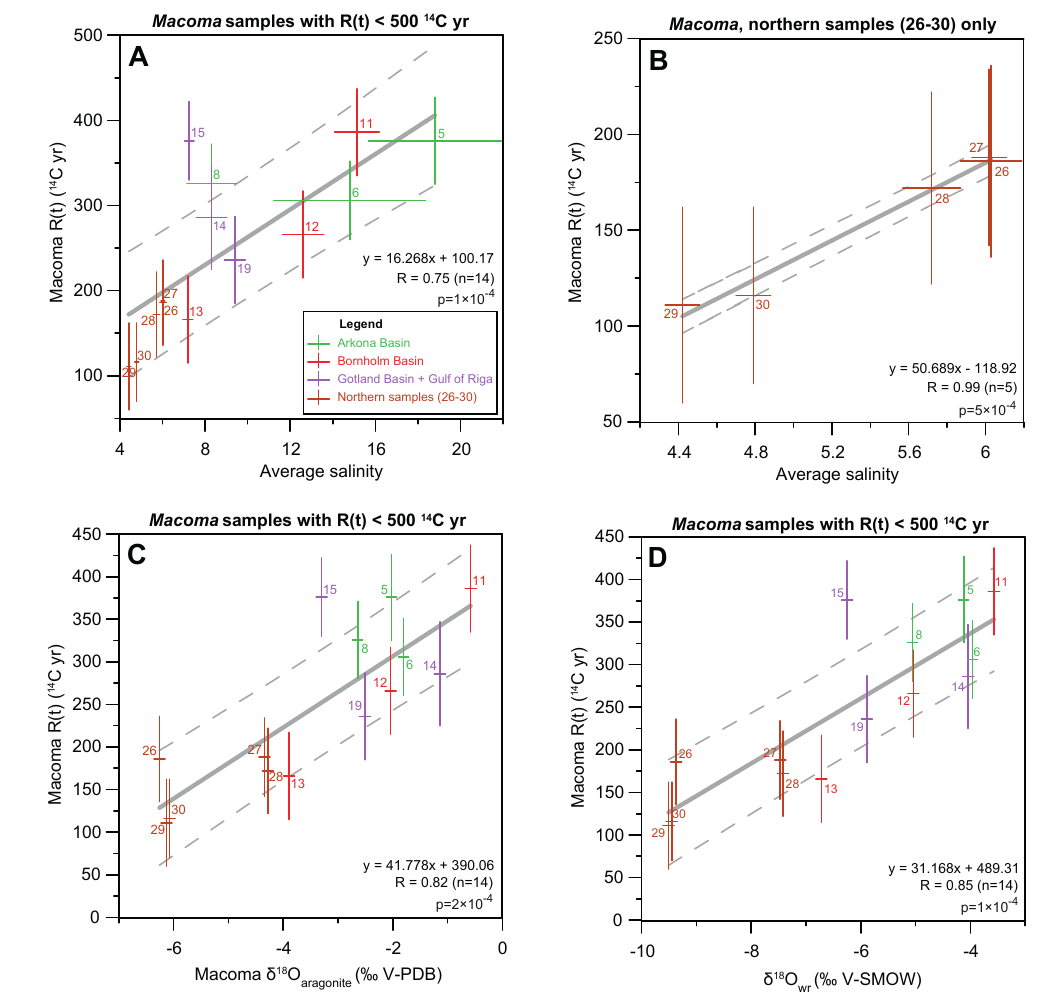
Fig. 5. (A) R(t) vs. average salinity for Macoma samples with R(t)< 500 14 Cyr. (B) R(t) vs. average salinity for northern samples (locations 26–30) only. (C) R(t) vs. δ 18 O aragonite for Macoma samples with R(t)< 500 14 Cyr. (D) R(t) vs. δ 18 O wr (water reconstructed) for Macoma samples with R(t)< 500 14 Cyr, based on correction of δ 18 O aragonite for the temperature fractionation effect (see Sect. 4.2.5). For all figures: all error bars are 1 σ . Linear regression (grey line) with 1 σ confidence intervals (dashed line) also shown in some cases. Numbers next to data points indicate sample location numbers following Fig. 1 and Table